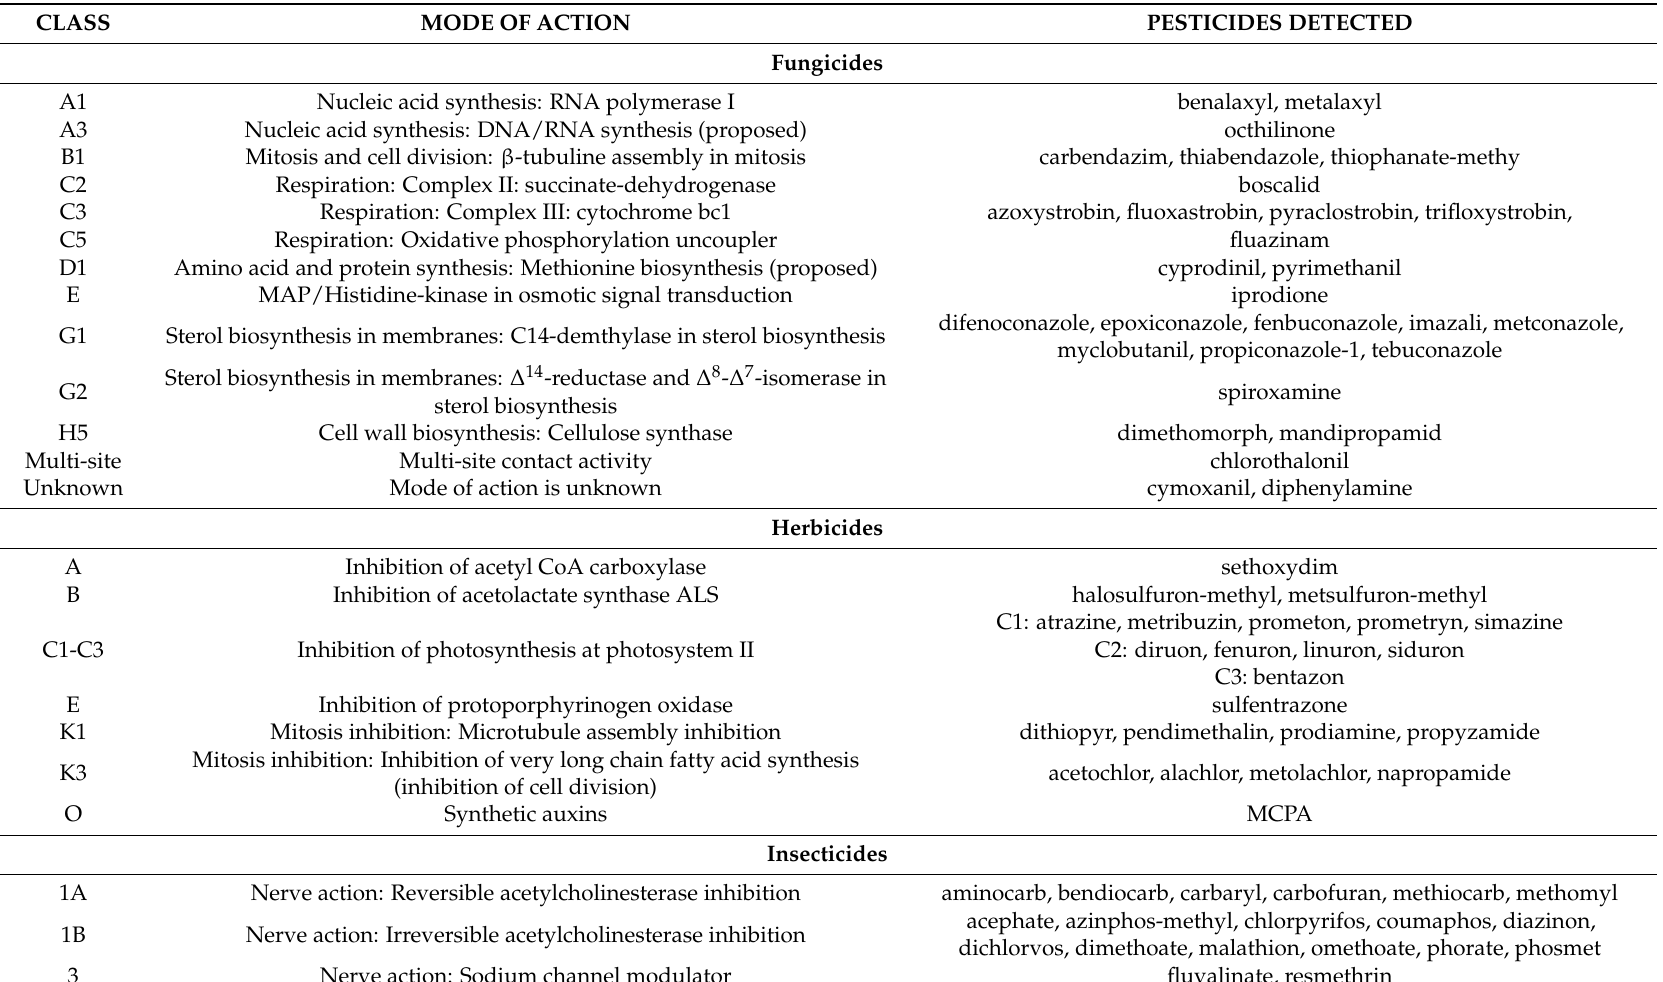
Table 8. Pesticide MOA for compounds detected in pollen and